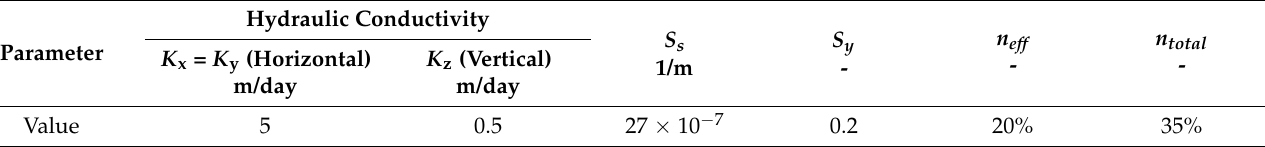
Table 1. Hydraulic Parameters for the hypothetical case study.